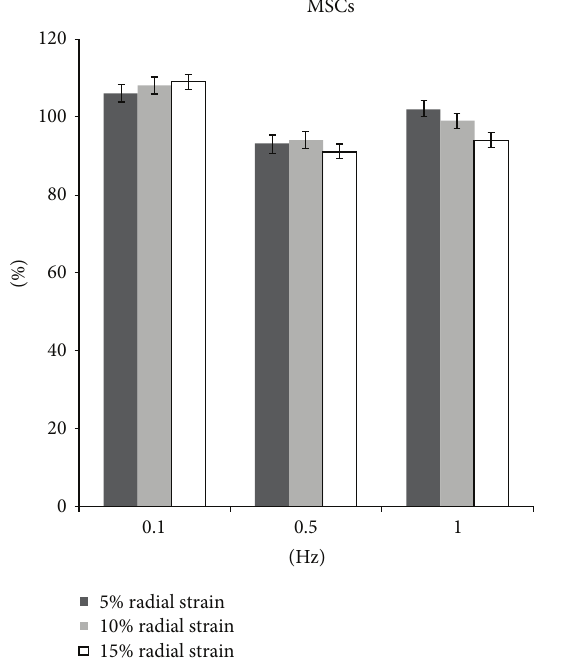
Figure 9: The proliferation of MSCs after radial stretch stimulation.